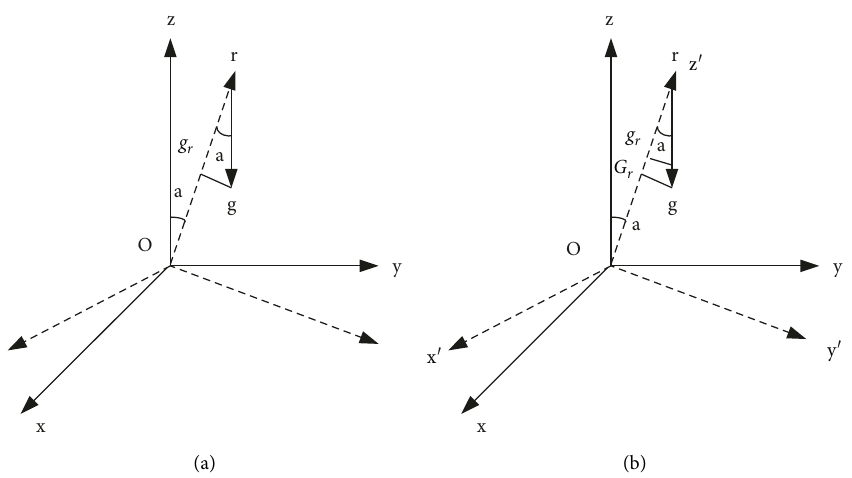
Figure 4: Simulation diagram of sensor coordinate system and schematic diagram of rotation model.